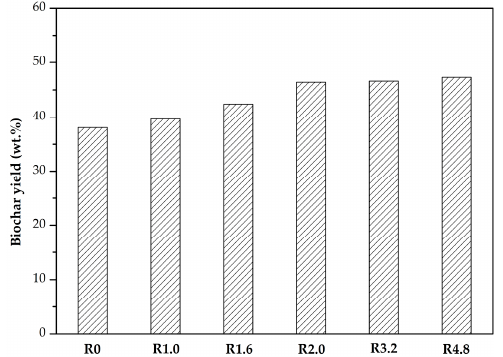
Figure 1. Biochar yields from the pyrolysis of rice husks with different boric acid contents. (R0, R1.0, R1.6, R2.0, R3.2, and R4.8 were rice husks with boric acid contents of 0, 1.0 wt %, 1.6 wt %, 2.0 wt %, 3.2 wt %, and 4.8 wt %, respectively.)